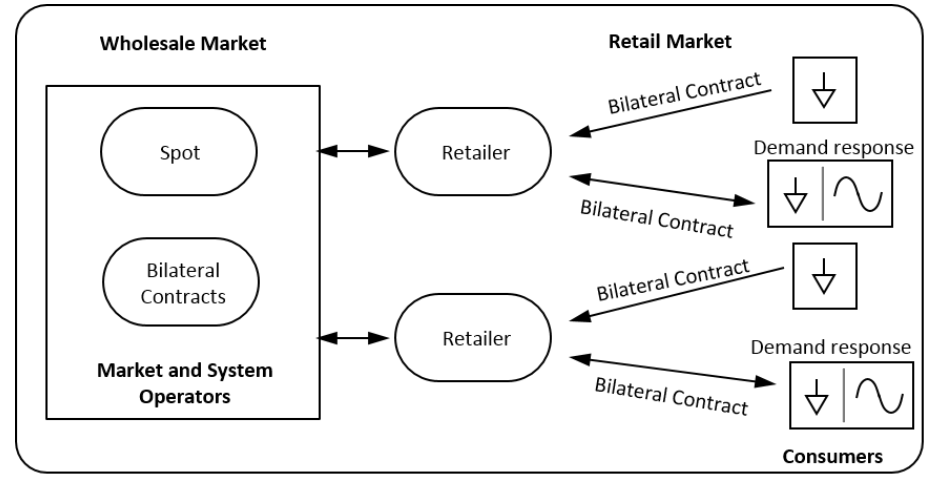
Figure 1. Multi-agent electricity market involving a wholesale market and a retail market (adapted from